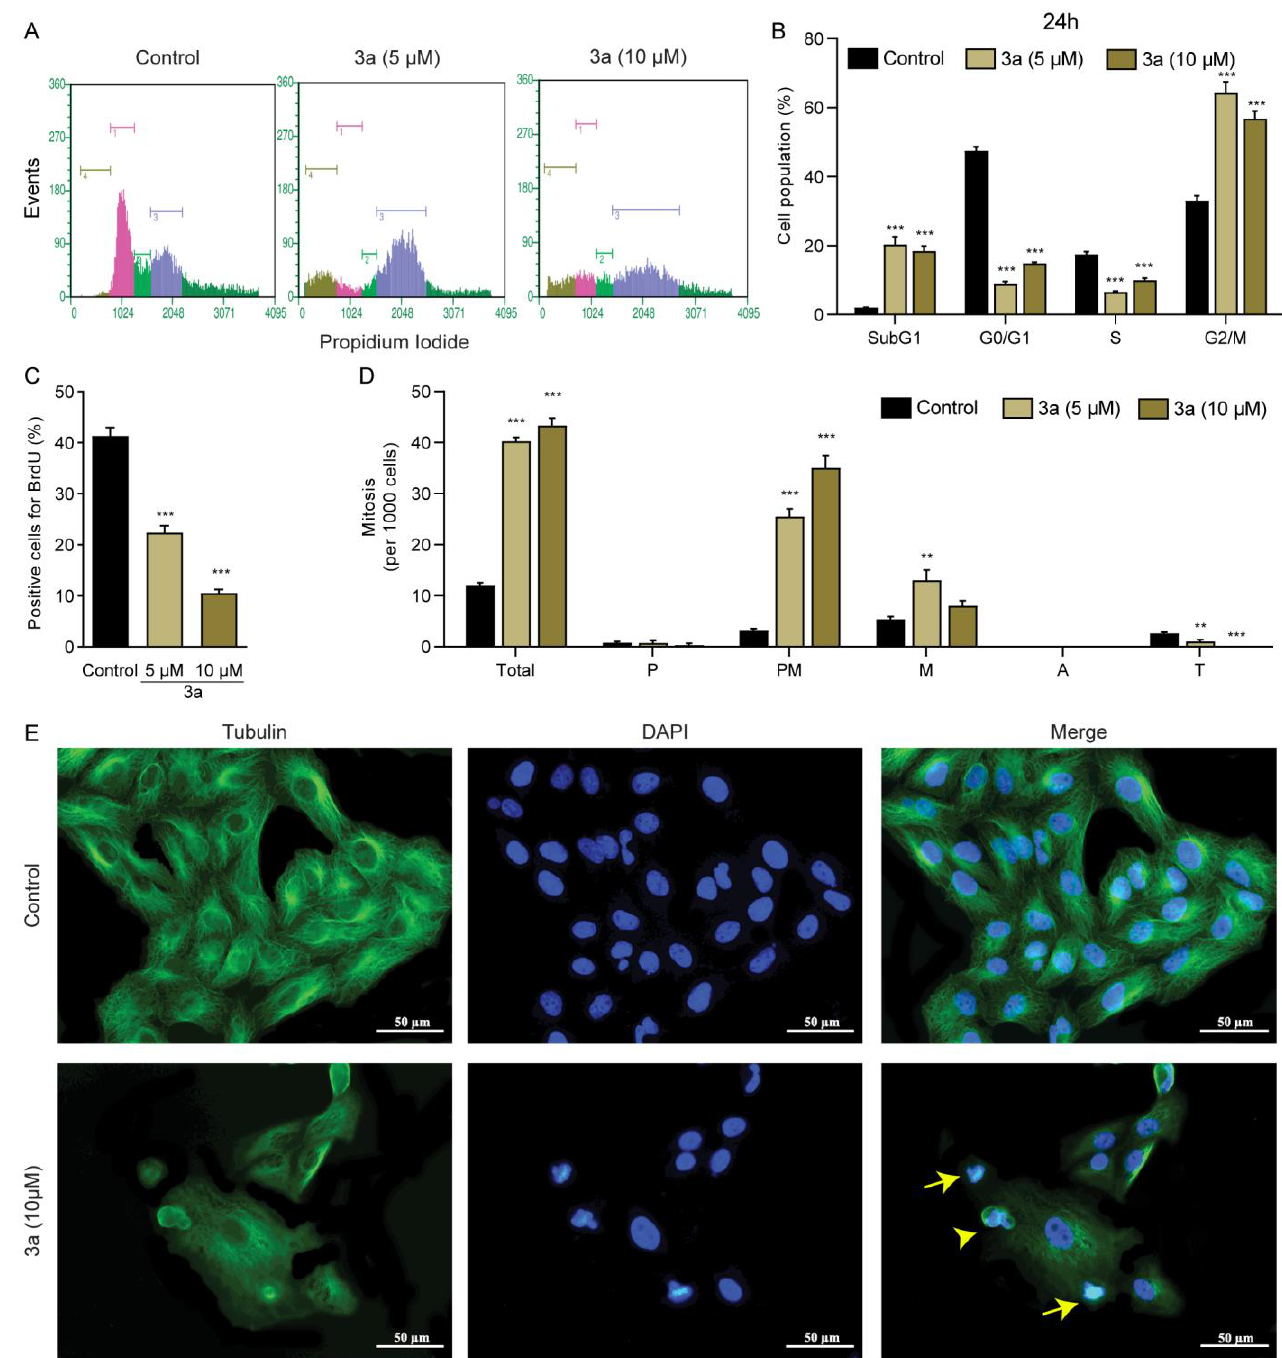
Figure 3. Compound 3a induced mitotic arrest at prometaphase in SK-MEL-147 cells. ( A , B ) Representative histograms obtained by flow cytometry and cell cycle analysis. SK-MEL-147 cultures were treated for 24 h with 3a at 5 and 10 µ M. Sub-G1 (brown), G0/G1 (pink), S (green), G2/M (blue), hypertetraploid population (dark green). ( C ) BrdU-positive cells determined after 24 h of treatment. ( D ) Mitotic indices determined after 24 h of treatment by counting the mitosis from cytological preparations labeled with DAPI and anti- α -tubulin. ** p < 0.01 and *** p < 0.001 according to ANOVA followed by Dunnet post-test compared with the control group. ( E ) Representative images of cells treated with 3a at 10 µ M showing abnormal spindle formation (arrowhead) and metaphase with failure of chromosome alignment at metaphase (arrows). DAPI: 4 (cid:48)